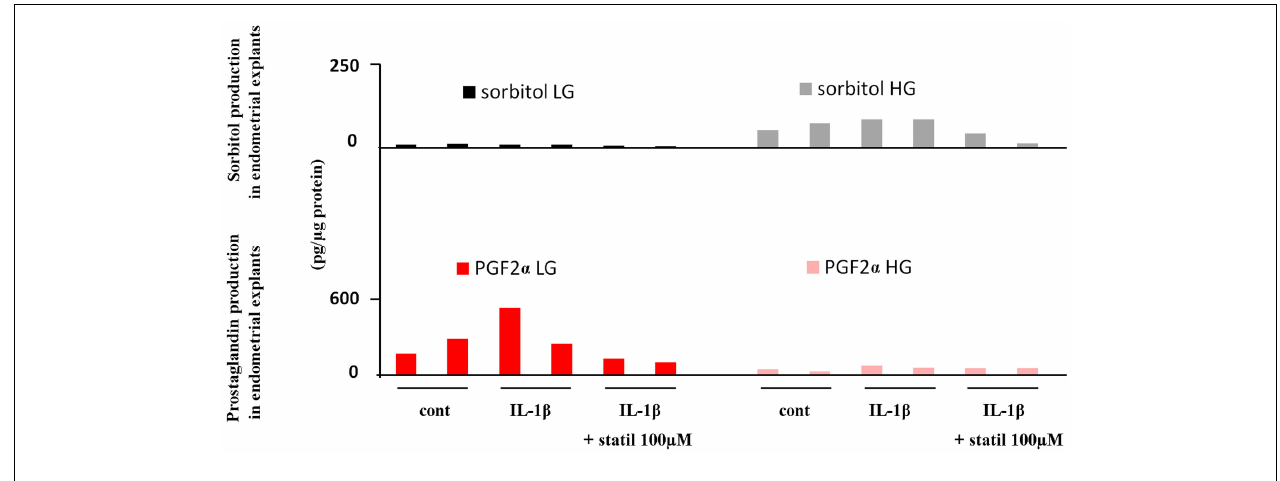
in presence or absence of Statil (ponalrestat, 100 μ M) under normal (LG) 5mg/ml or High (HG) 25mg/ml glucose concentrations. PGF2 α production was measured by EIA. Results from two different experiments are